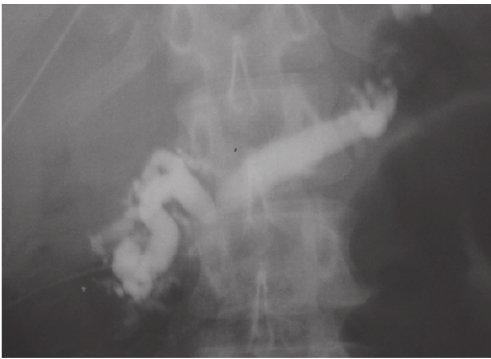
Figure 4- Pancreatic ductogram via the minor papilla cannulation. Santorini’s duct was dominant and trended from the anterior part of the pancreatic head to tail.